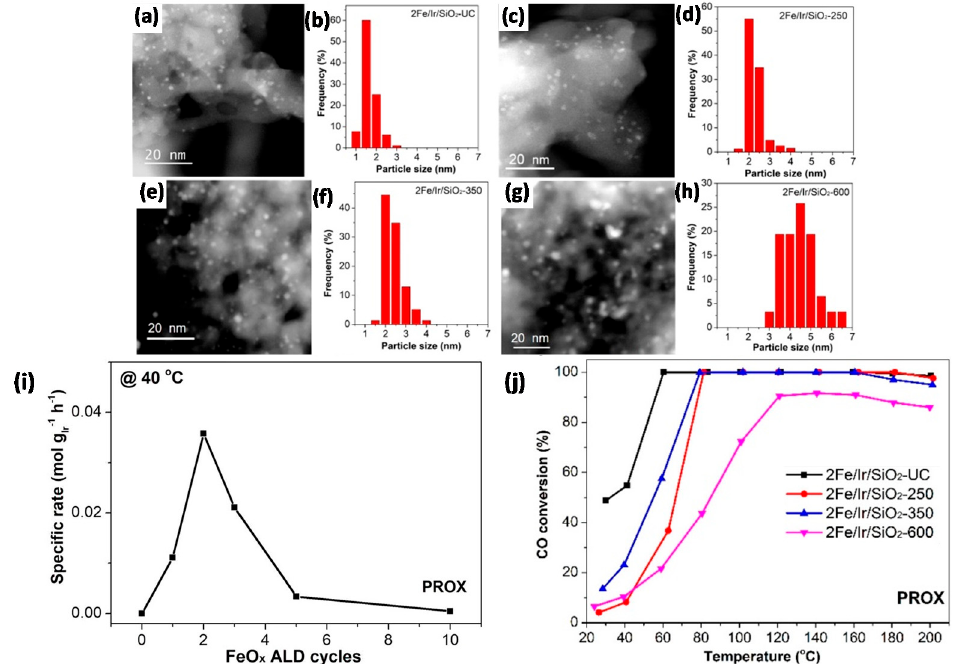
Figure 19. HAADF-STEM and corresponding particle size distributions for ( a )–( b ) uncalcined 2-Fe/Ir/SiO 2 ALD catalysts (2-Fe/Ir/SiO 2 -UC), and calcined in air at ( c )–( d ) 250 °C (2-Fe/Ir/SiO 2 -250), ( e )–( f ) 350 °C (2-Fe/Ir/SiO 2 -350) and ( g )–( h ) 600 °C (2-Fe/Ir/SiO 2 -600). ( i ) Specific rate of Fe/Ir/SiO 2 -350 catalysts in the PROX reaction at 40 °C as a function of the number of applied FeO x ALD cycles. ( j ) CO conversion as a function of temperature for 2Fe/Ir/SiO 2 catalysts in the PROX reaction. Reaction condition for ( i ) and ( j ): 1% ( V / V ) CO, 1% ( V / V ) O 2 , 48% ( V / V ) H 2 , Ar balance. WHSV = 18,000 mL h − 1 g cat − 1 . Adapted with permission from Ref. [295]. Copyright 2019 American Chemical Society.